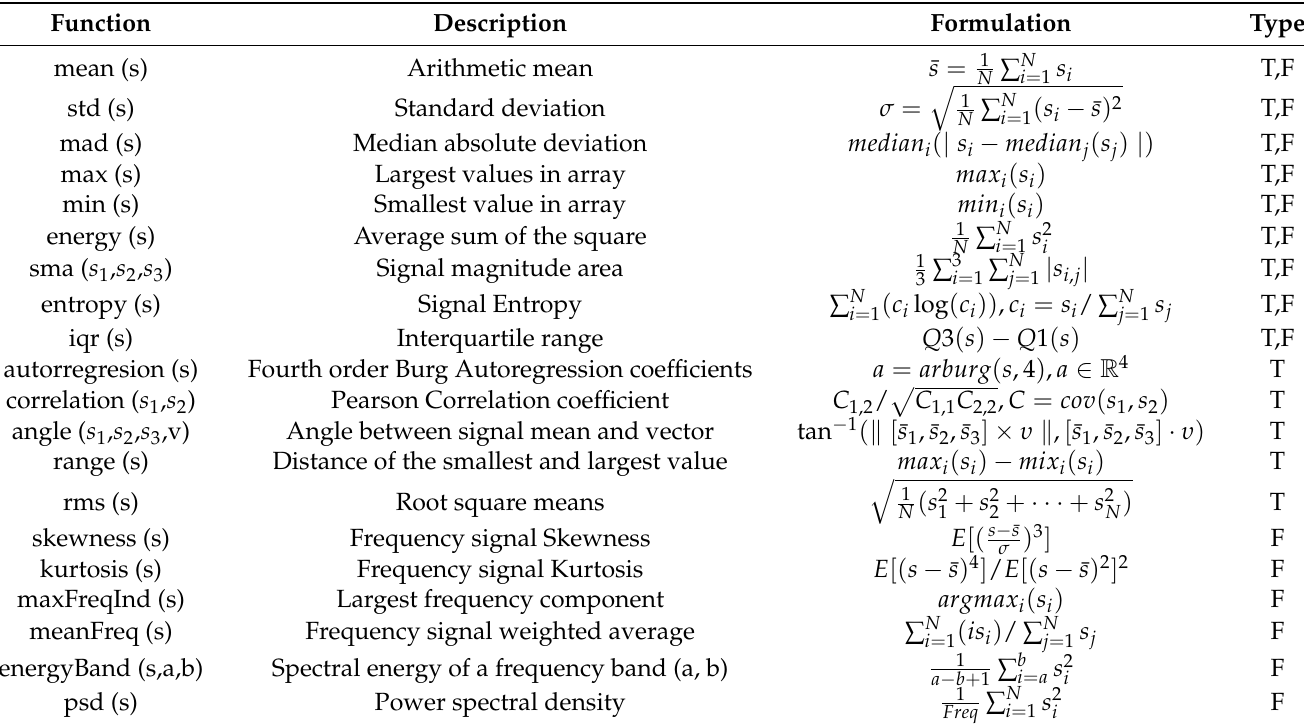
Table 1. Feature Lists.